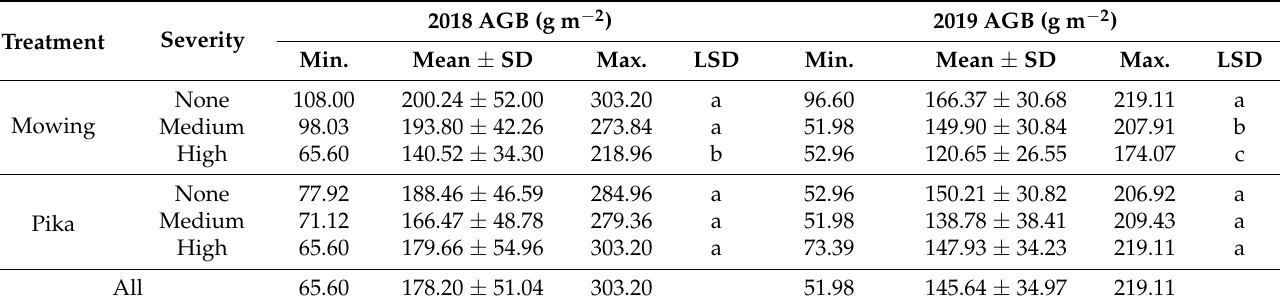
Table 2. The summary of field measured